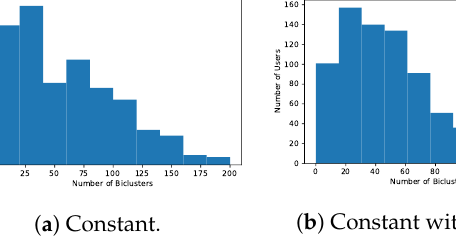
Figure 28. Number of patterns found for each user when combining the biclustering solutions obtained from datasets of different granularity at InfraQuinta,